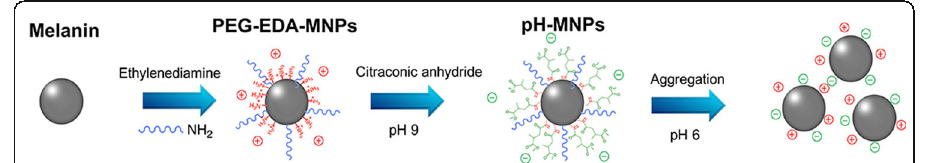
Fig. 1 Schematic illustration of the preparation process of the pH-MNPs. (Reproduced from Liu Q, Fang H, Gai Y, Lan X. pH-Triggered Assembly of Natural Melanin Nanoparticles for Enhanced PET Imaging. Front Chem.